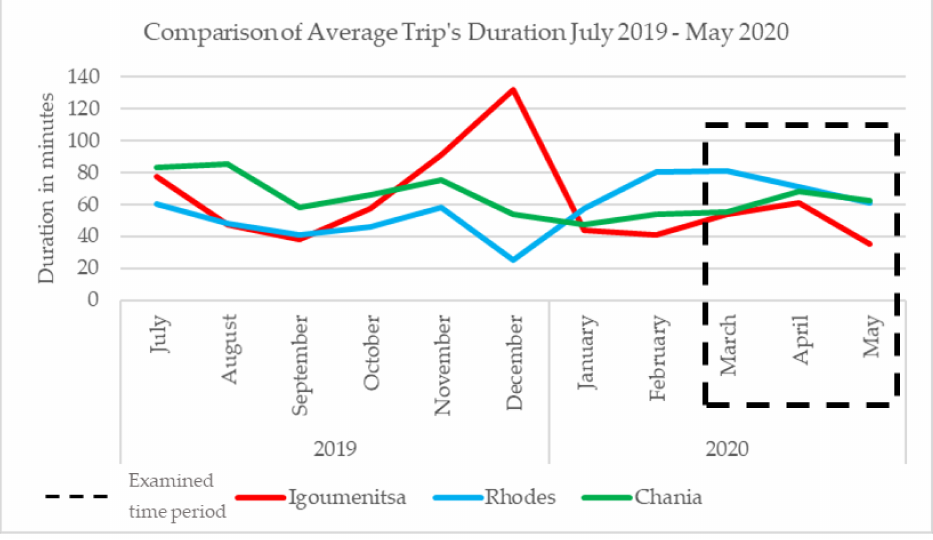
Figure 10. Comparison of the average trip’s duration for the cities of Igoumenitsa, Rhodes,